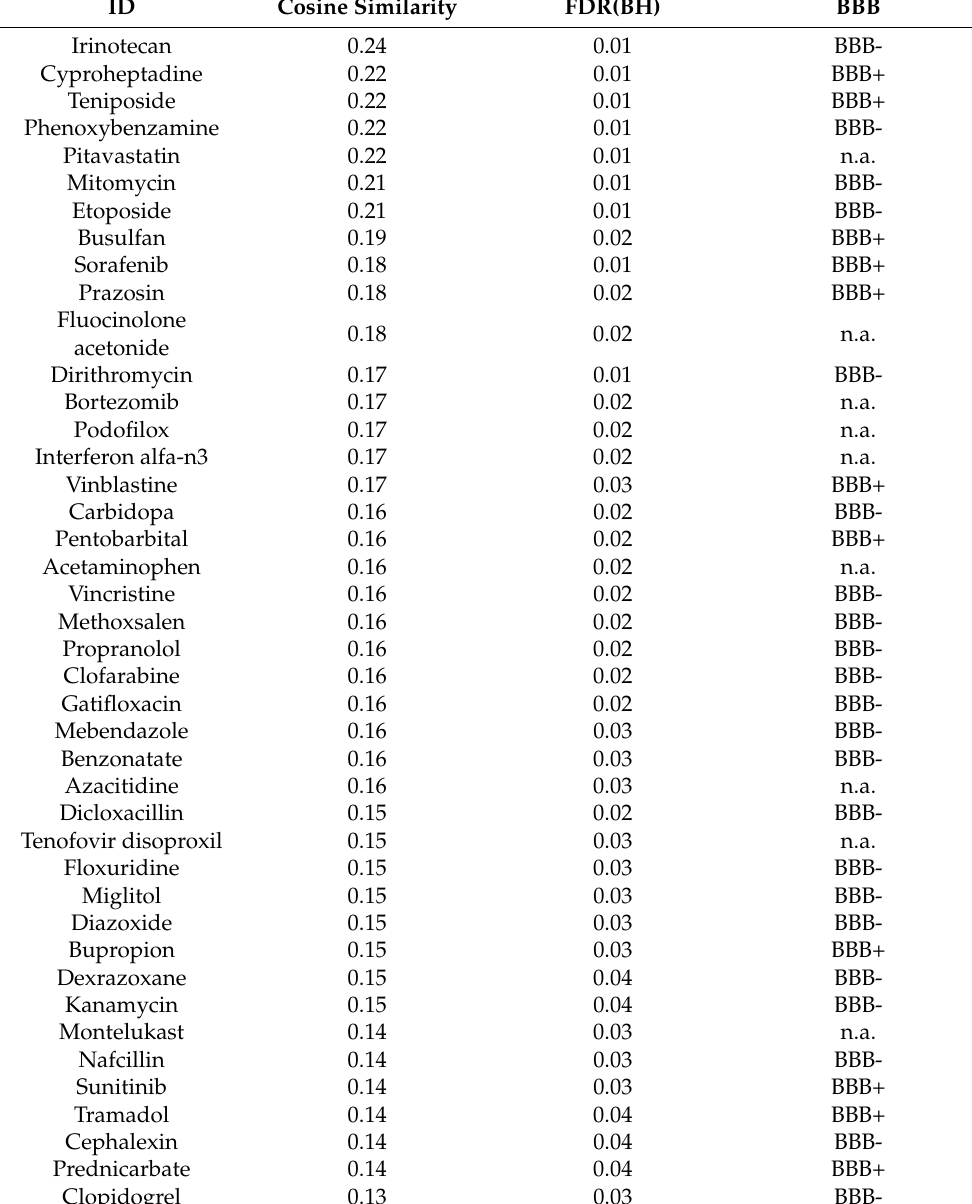
Table 3. Predicted drugs predisposed to